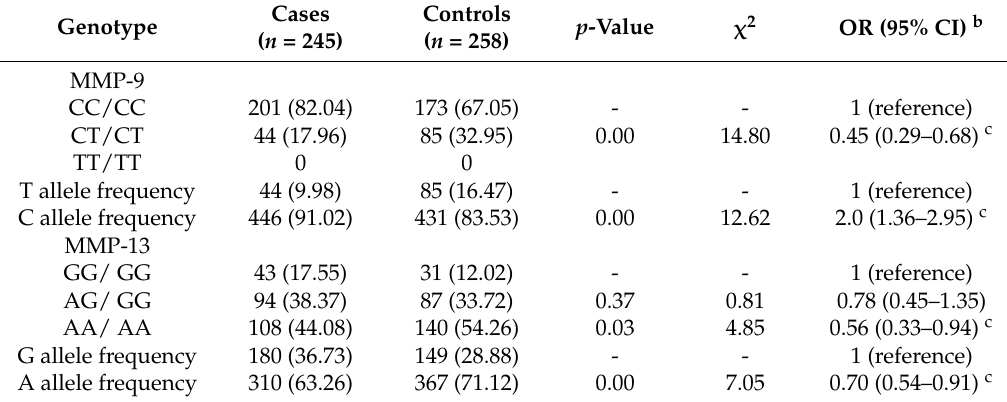
Table 4. Allele frequencies of MMP-9 and MMP-13 among cases and controls.